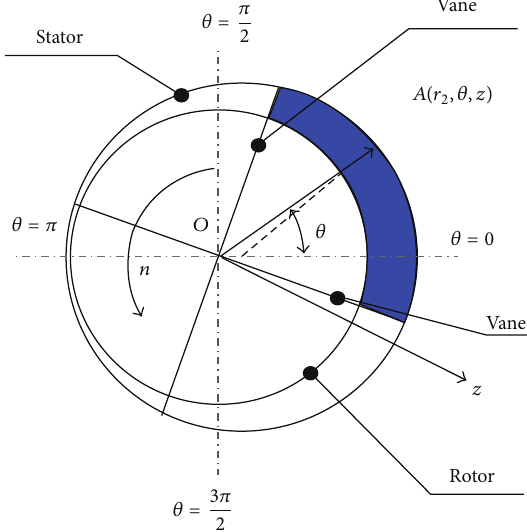
Figure 3: The melt conveying model in a chamber of